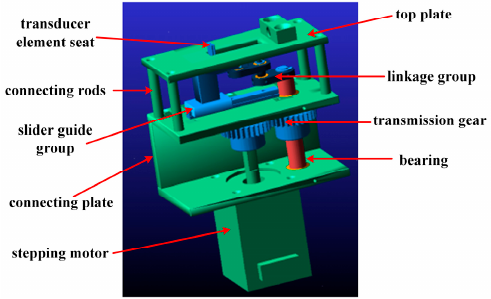
Figure 1. The schematic of the mechanical scanning module.